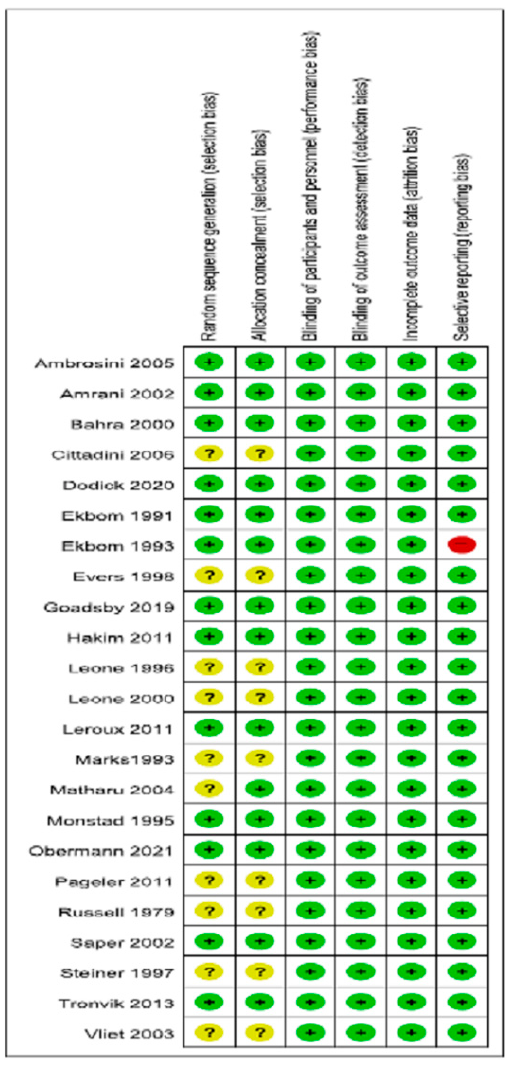
Figure 10. Risk-of-bias assessment of the studies. High risk of bias was marked as red ( − ), low risk of bias was marked as green (+) and unclear risk of bias was marked as yellow (?).